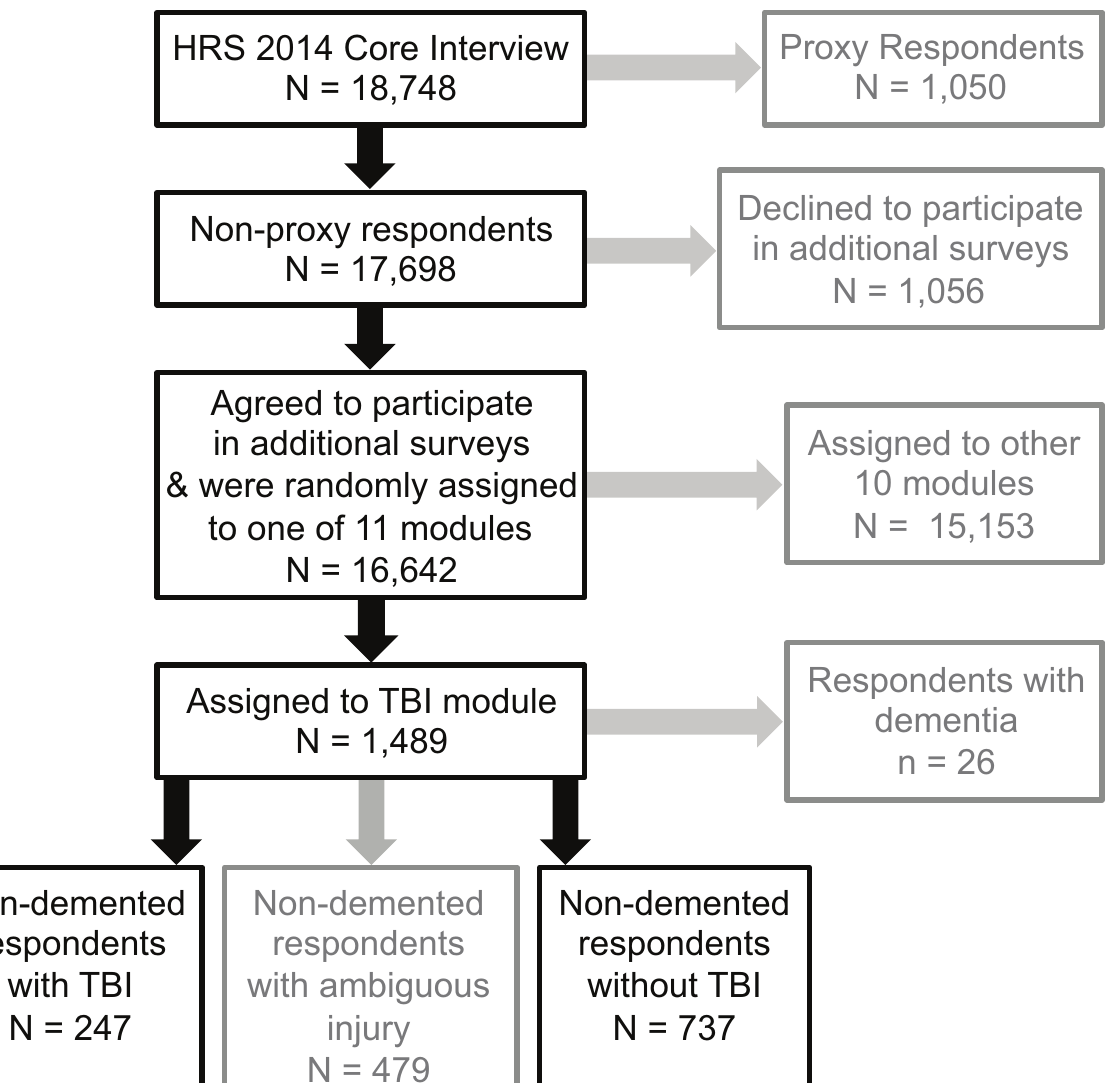
Fig 1. Sampling of respondents. The cohort for this study was derived from a randomsub-sampleof non-proxyrespondentsto the 2014 wave of the Health and RetirementStudy (HRS) who were randomly assignedto participate in a traumatic brain injury (TBI) module. Text in grey represents respondents excludedfrom this